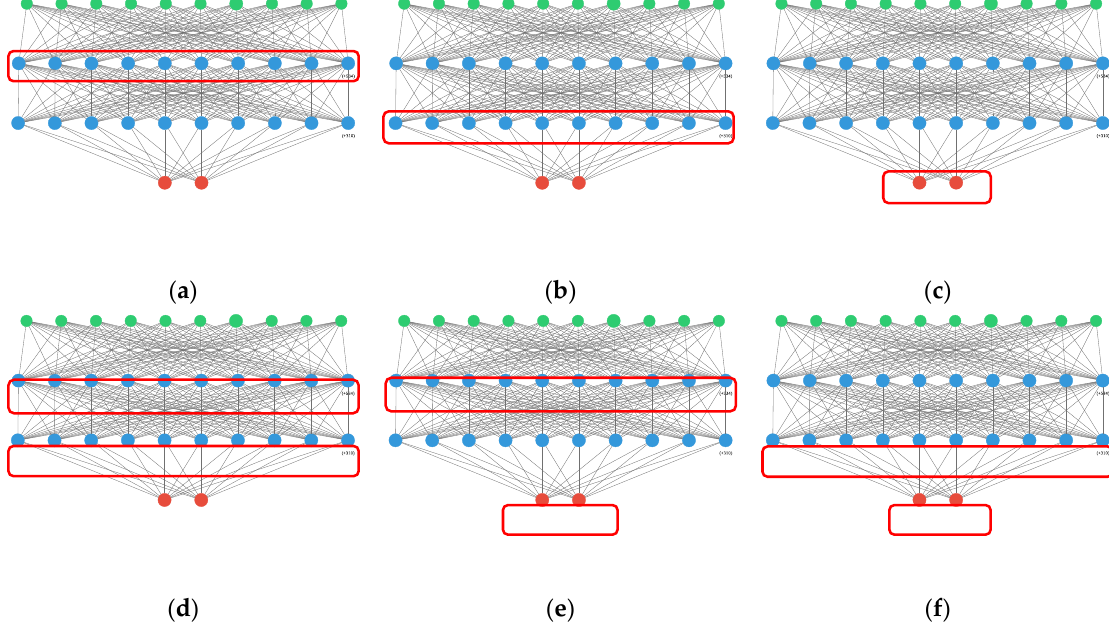
Figure 12. Six different types of models in transfer learning process: ( a ) T0 model fixed layer 0, ( b ) T1 model fixed layer 1, ( c ) T2 model fixed layer 2, ( d ) T01 model fixed layer 0 and 1, ( e ) T02 model fixed layer 0 and 2, and ( f ) T12 model fixed layer 1 and 2. Table 4. Classification results of different models in transfer learning.